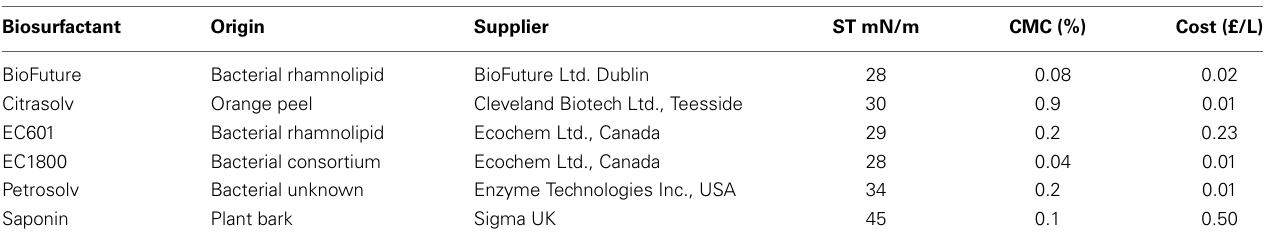
Table 2 | Cost of biosurfactant per liter of solution (diluted and the CMC based cost calculation carried out by Connolly et al., 2010).